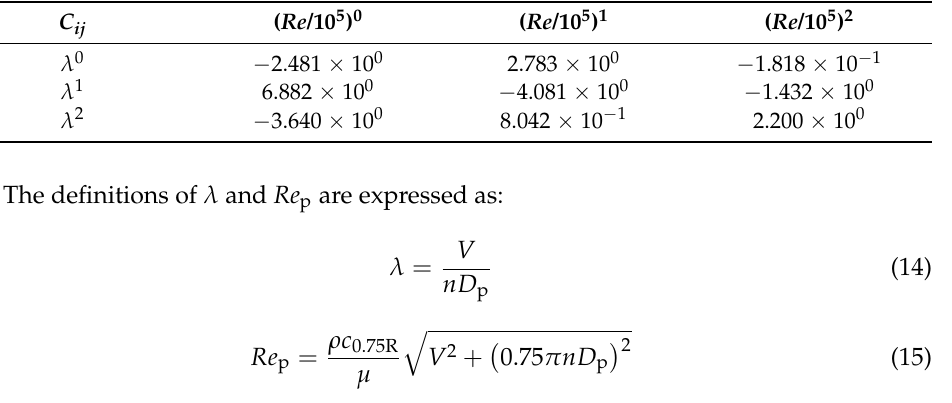
12 of 28 Figure 13. Propeller wind tunnel test. The efficiency coefficients of the motor under different working conditions are shown in Figure 14. When designing the flight profile, interpolation calculation will be carried out according to the data in the figure. When the UAV is at a lower flying altitude, the propeller speed is also lower, indicating that the motor torque under the same power is larger, and the efficiency of the motor in the maximum power state is lower. The variation curve of the motor efficiency with the flight height under the maximum continuous state is shown in Figure 15.